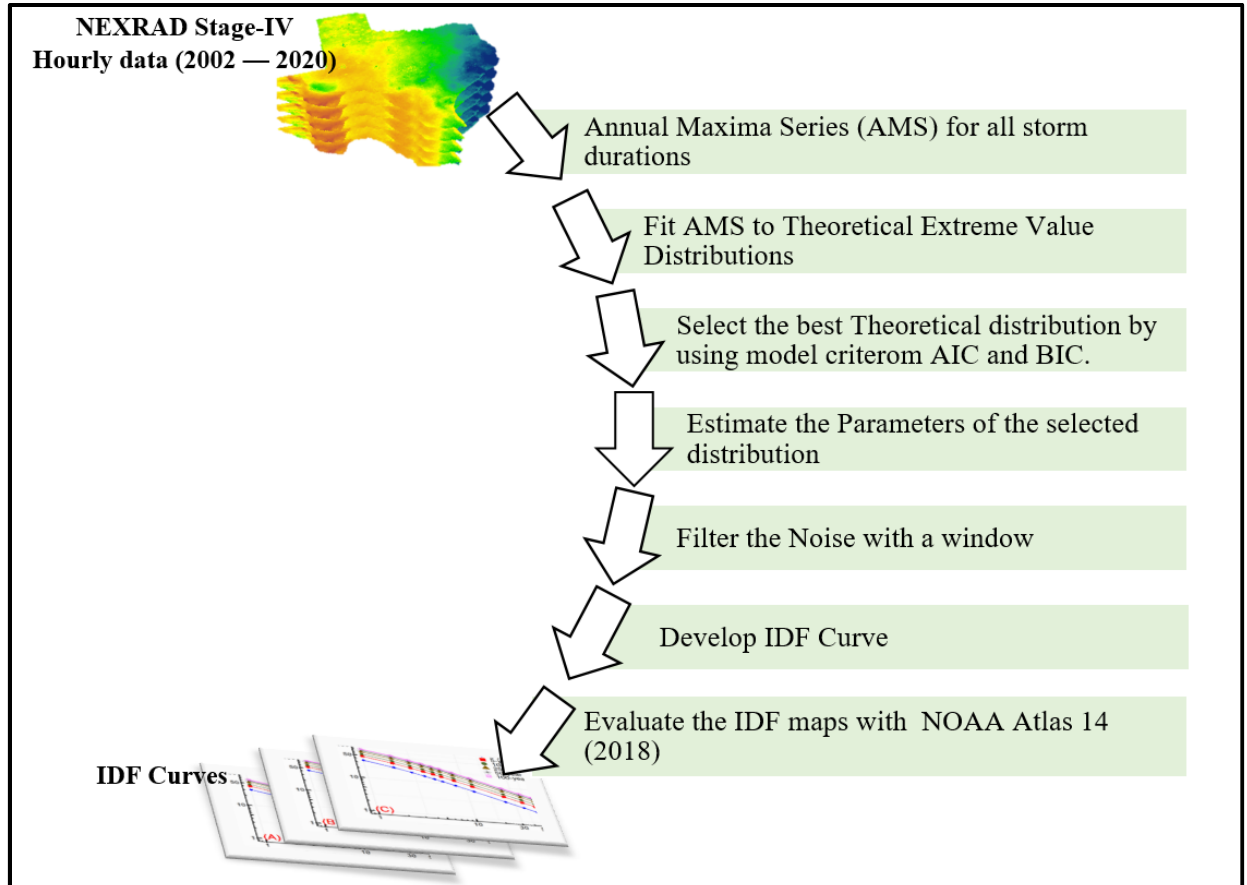
Figure 2. The path flow of the methodology followed in developing the IDF curves using the NEXRAD Stage-IV hourly data for the state of Texas.